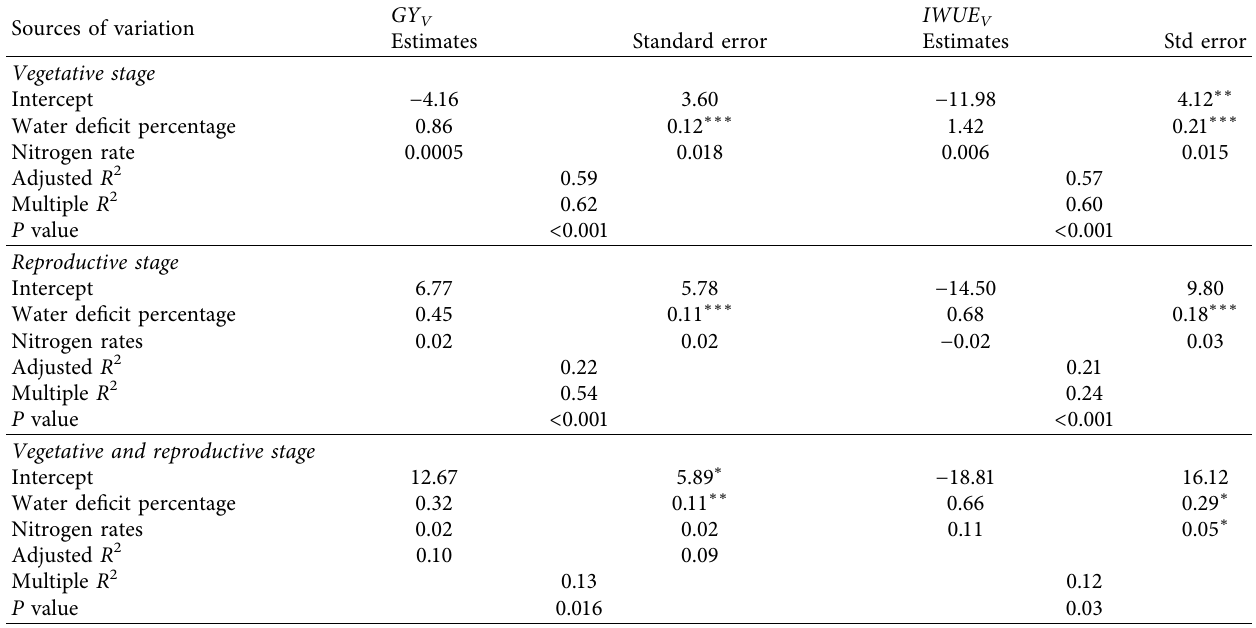
Table 2: Multiple linear regression model of GY